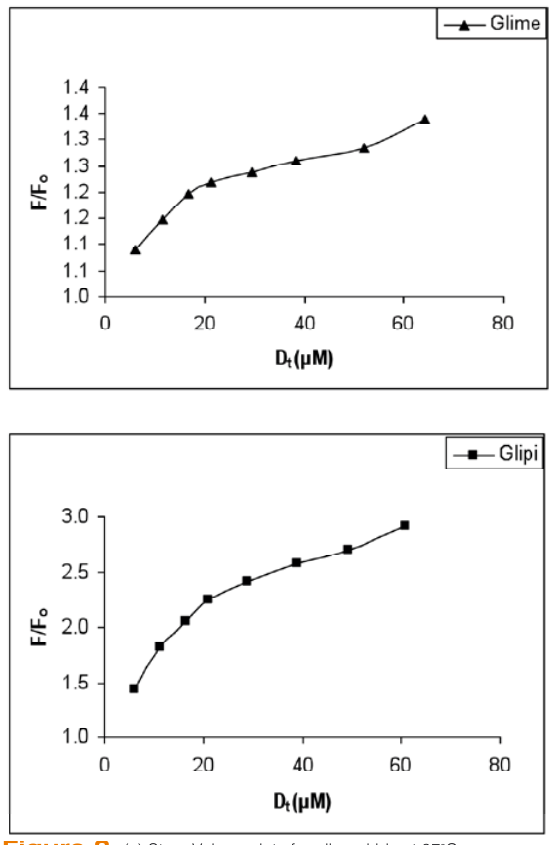
Figure 8. (a) Stern-Volmer plots for glimepiride at 37 0 C (b) Stern-Volmer plots for glipizide at 37 0 C